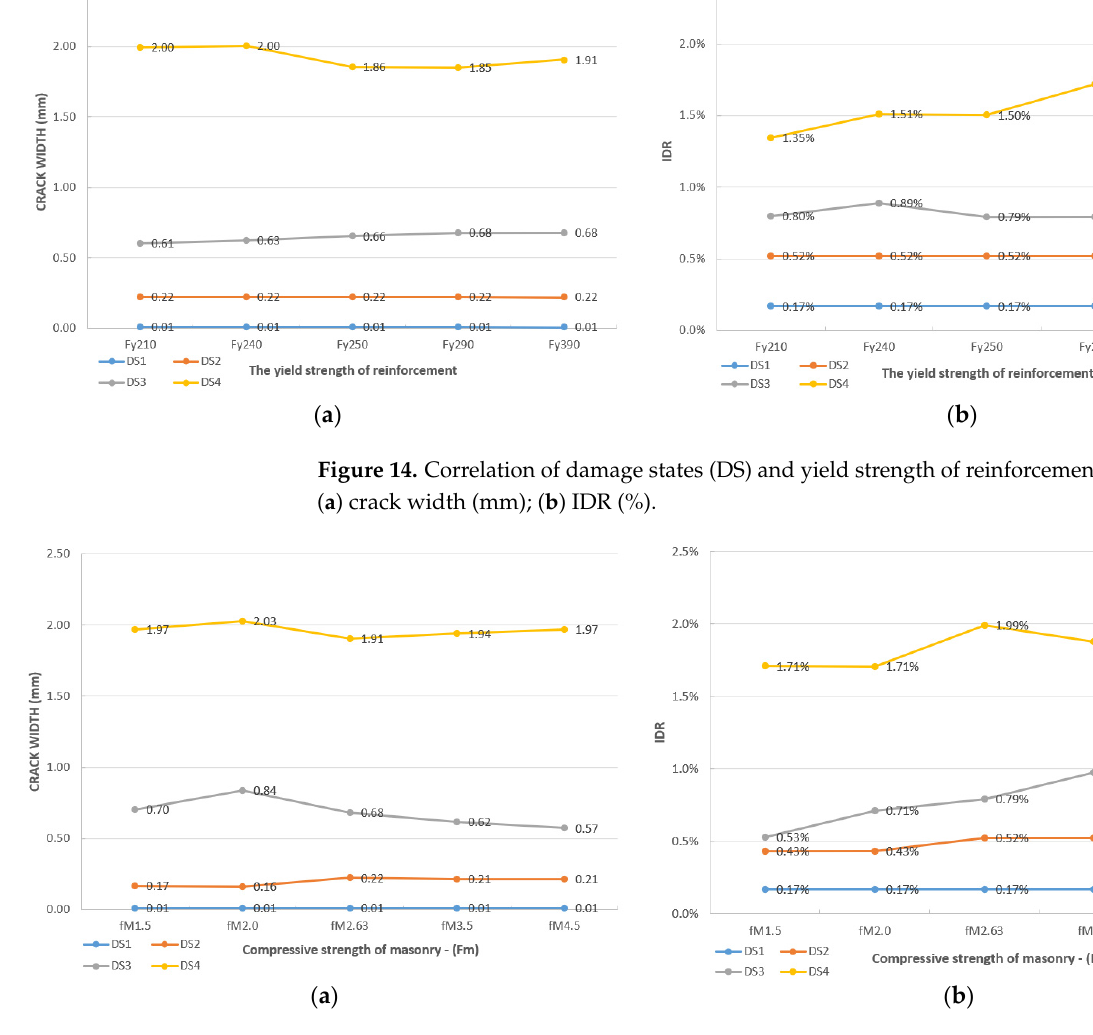
Figure 15. Correlation of damage states (DS) and the compressive strength of masonry (Fm) associated with: ( a ) crack width (mm); ( b ) IDR (%).